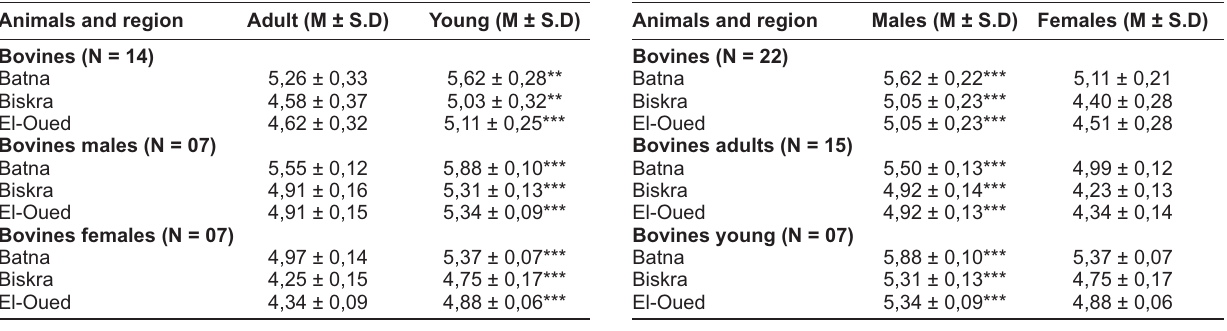
Table-1. Influence of age on the size of bovine erythrocytes (expressed in µm ) Animals and region